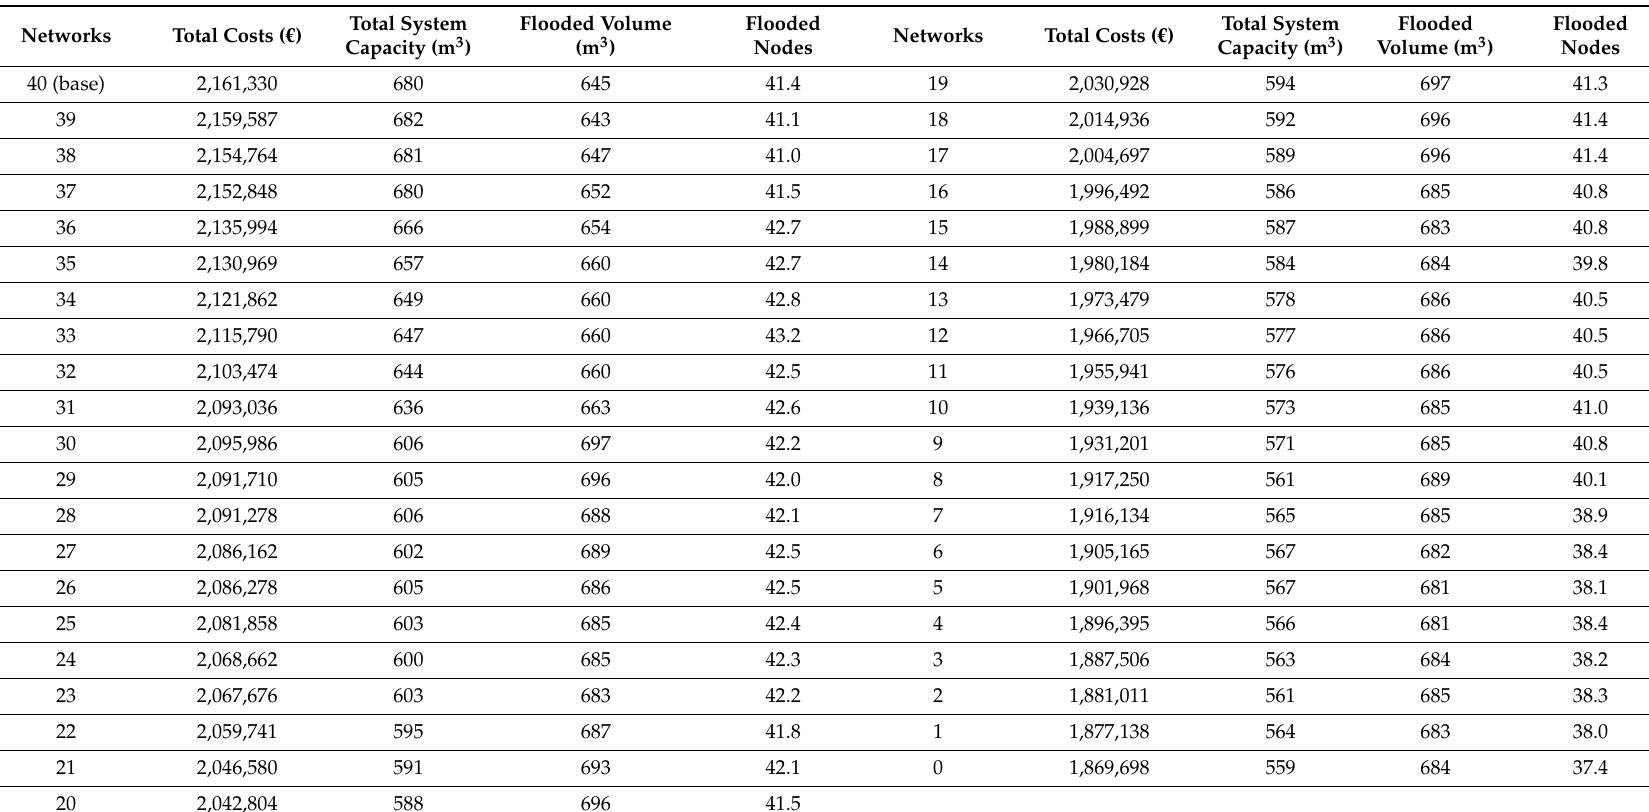
Table A2. Total construction costs ( € ), total system capacity (m 3 ), total weighted flooded volume (m 3 ) and total weighted number of flooded nodes for all 41 networks in which extra pipes are removed from downstream (scenario